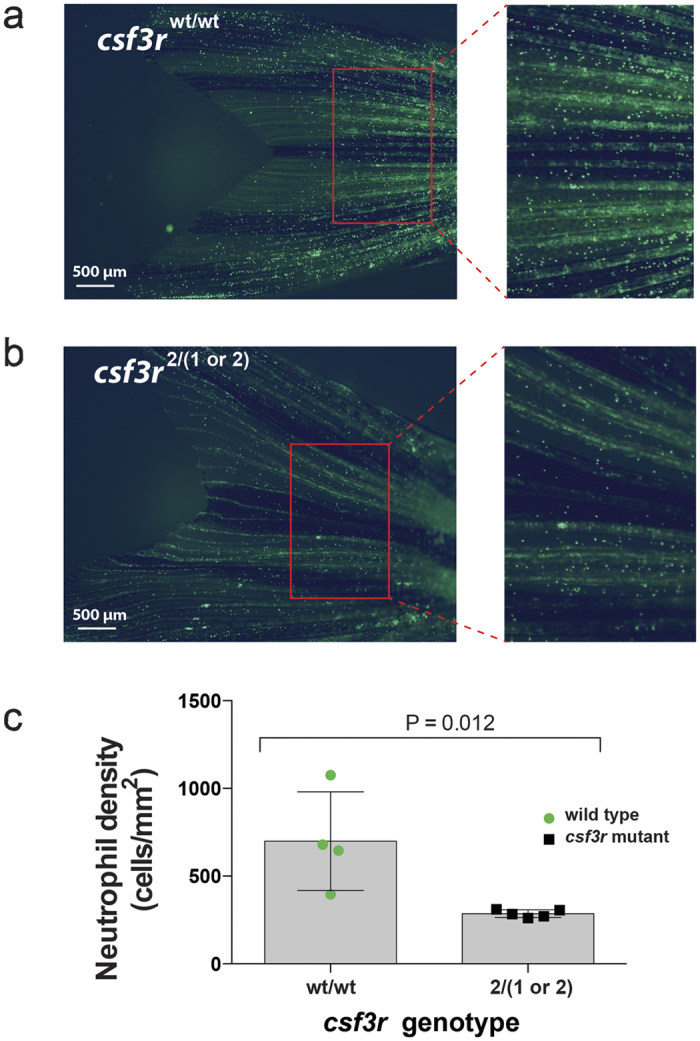
Neutrophil deficiency in csf3r null adults.(a,b) Fluorescent photomicrographs of 5 month old adult Tg(mpx:EGFP) zebrafish tail fins showing reduced numbers of EGFP-positive neutrophils in csf3r null (b) vs WT (a) animals. (c) Quantification of tail fin neutrophil density. n = 4–5 animals/genotype as shown.